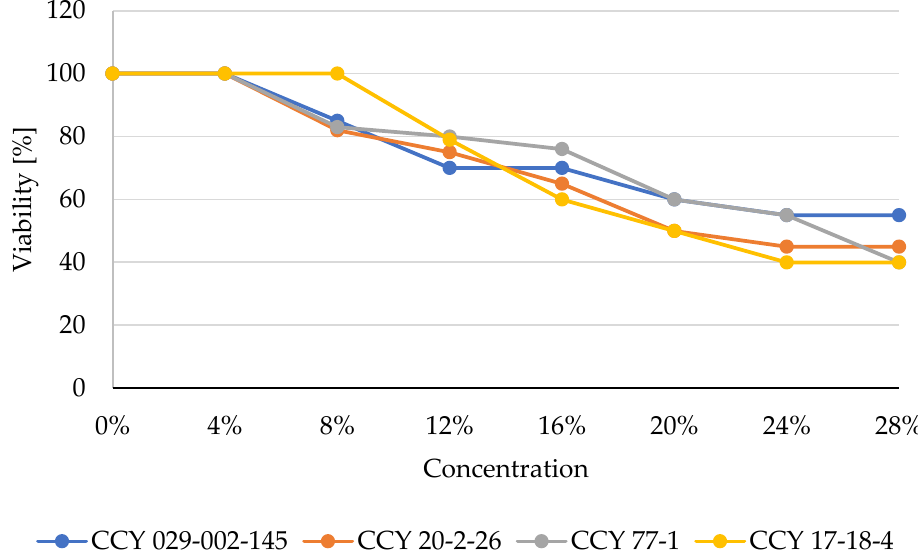
Figure 6. Cytotoxic effect of rehydrated yeast biomass in the concentration range of 4 – 28%.